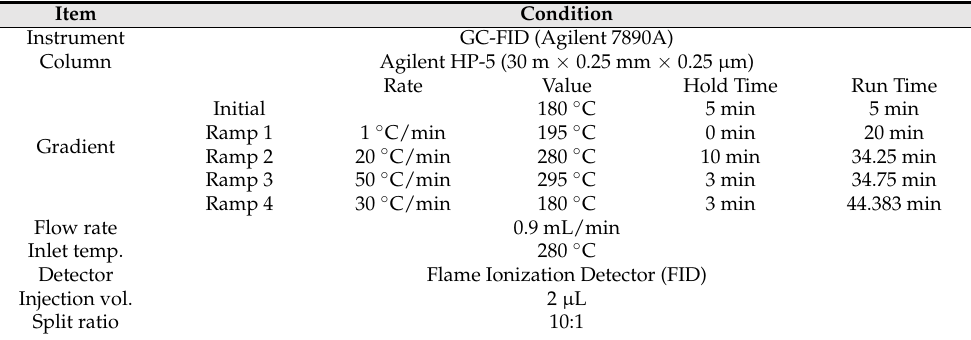
Table 1. GC/FID analysis conditions for accurate analysis of galactose